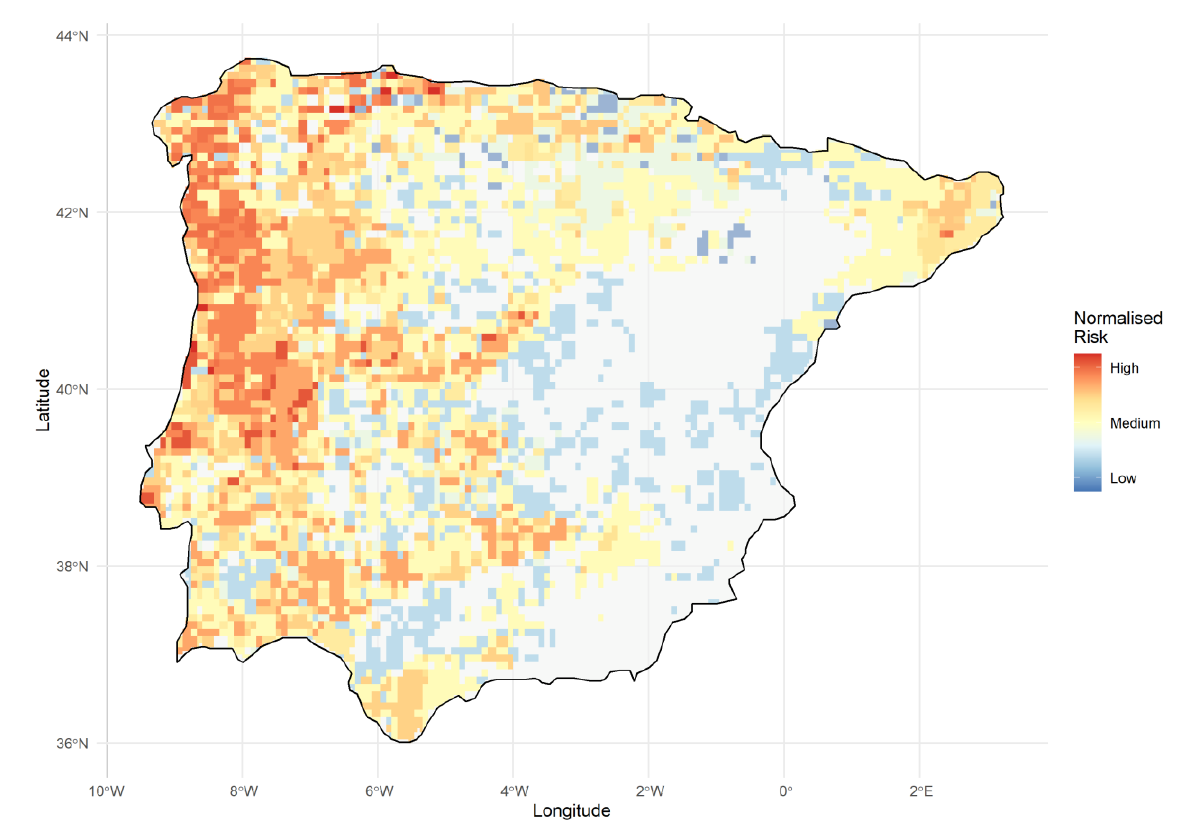
Figure 3. Spatial prediction of risk to Iberian urodeles from Bsal introduction. Each cell (10 km × 10 km) represents the normalized risk to biodiversity loss, given both species richness and the predicted susceptibility of inhabitants to Bsal infection. Darker red cells, as in the northwest/west regions of the peninsula, indicate areas likely to be most at risk should Bsal be introduced. Transparent gray cells are those with no salamander inhabitants.